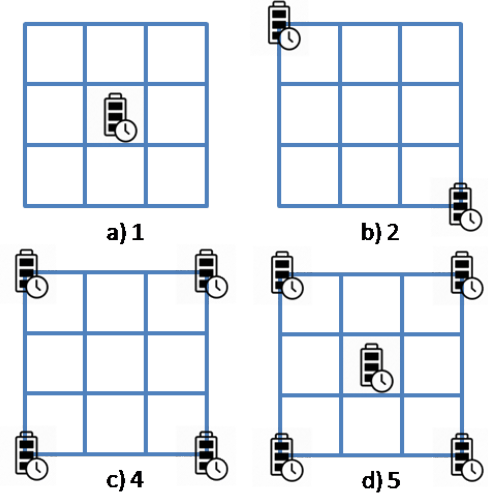
Figure 6. Charging stations placement with a typical UAV